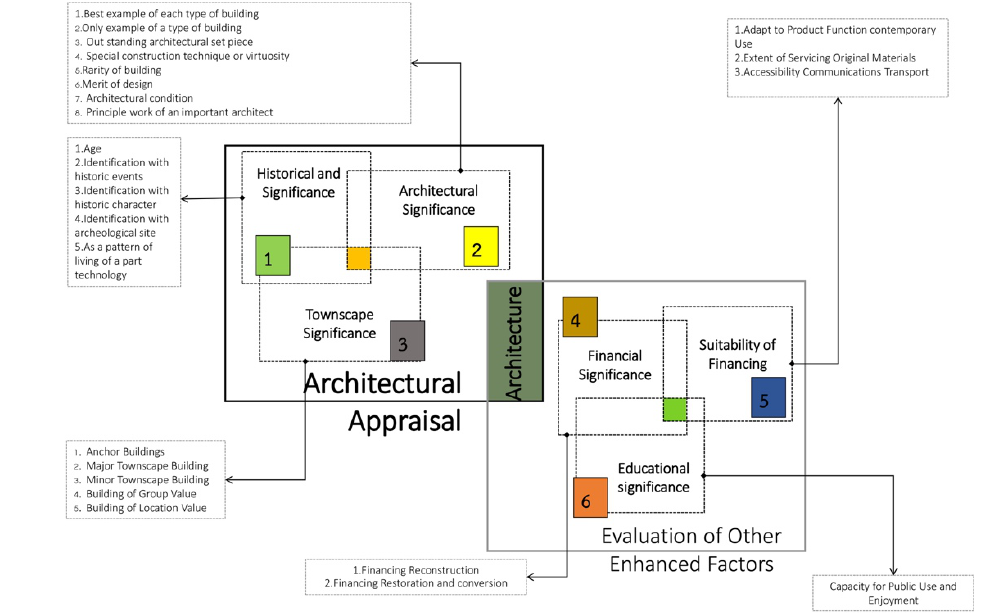
Figure 1. Conceptual Framework of Architectural Values from Relevant People in the